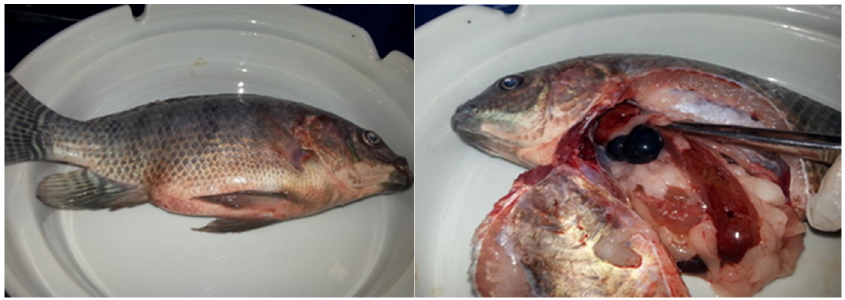
Figure 5. Clinical signs after infection with Aeromonas hydrophila . Hematological and Biochemical Parameters after the Challenge Test To evaluate the influence of the challenge test with Aeromonas hydrophila and Pseudomonas fluorescens on the physiological condition of the Nile tilapia, an analysis of hematological and biochemical indicators was performed (Table 4). After challenge testing, RBCc showed significant differences ( p < 0.05), with values in A. hydrophila and P. fluorescens variants being lower than those in positive and negative control variants. Hematocrit (PVC) showed significant differences ( p < 0.05), with values obtained for the A. hydrophila and P. fluorescens variants being significantly lower ( p < 0.05) than C + and C − control variants. For these two hematological parameters, significant differences ( p < 0.05) were recorded in batches that originated from the growth-period-specific control variant. After the challenge test, hemoglobin concentrations were significantly ( p < 0.05) lower in the A. hydrophila variant from the growth control variant and also significantly ( p < 0.05) lower in the P. fluorescens variant from the probiotic growth variant (V 1 ). MCV showed significant differences ( p < 0.05), with the values of the A. hydrophila variant being significantly higher in the control growth variant than in other challenge test variants. Table 4. Hematological parameters after challenge test with Aeromonas hydrophila and Pseudomonas fluorescens. Hematological Parameters